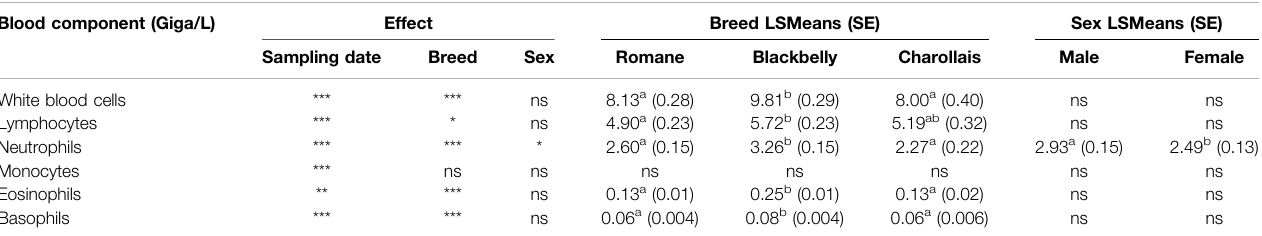
TABLE 3 | Effects of the sampling date, breed and the sex on the complete blood count. Blood component (Giga/L)